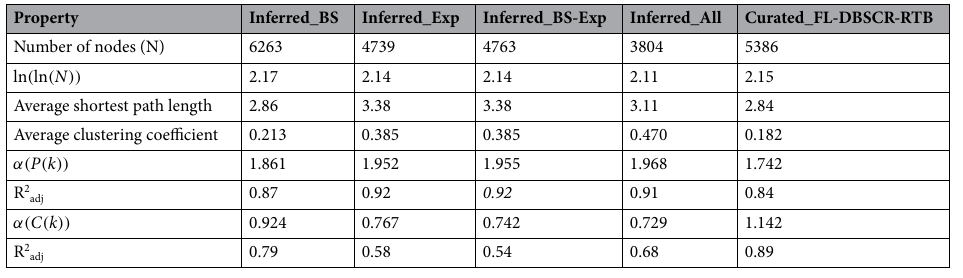
Table 2. Network properties for inferred